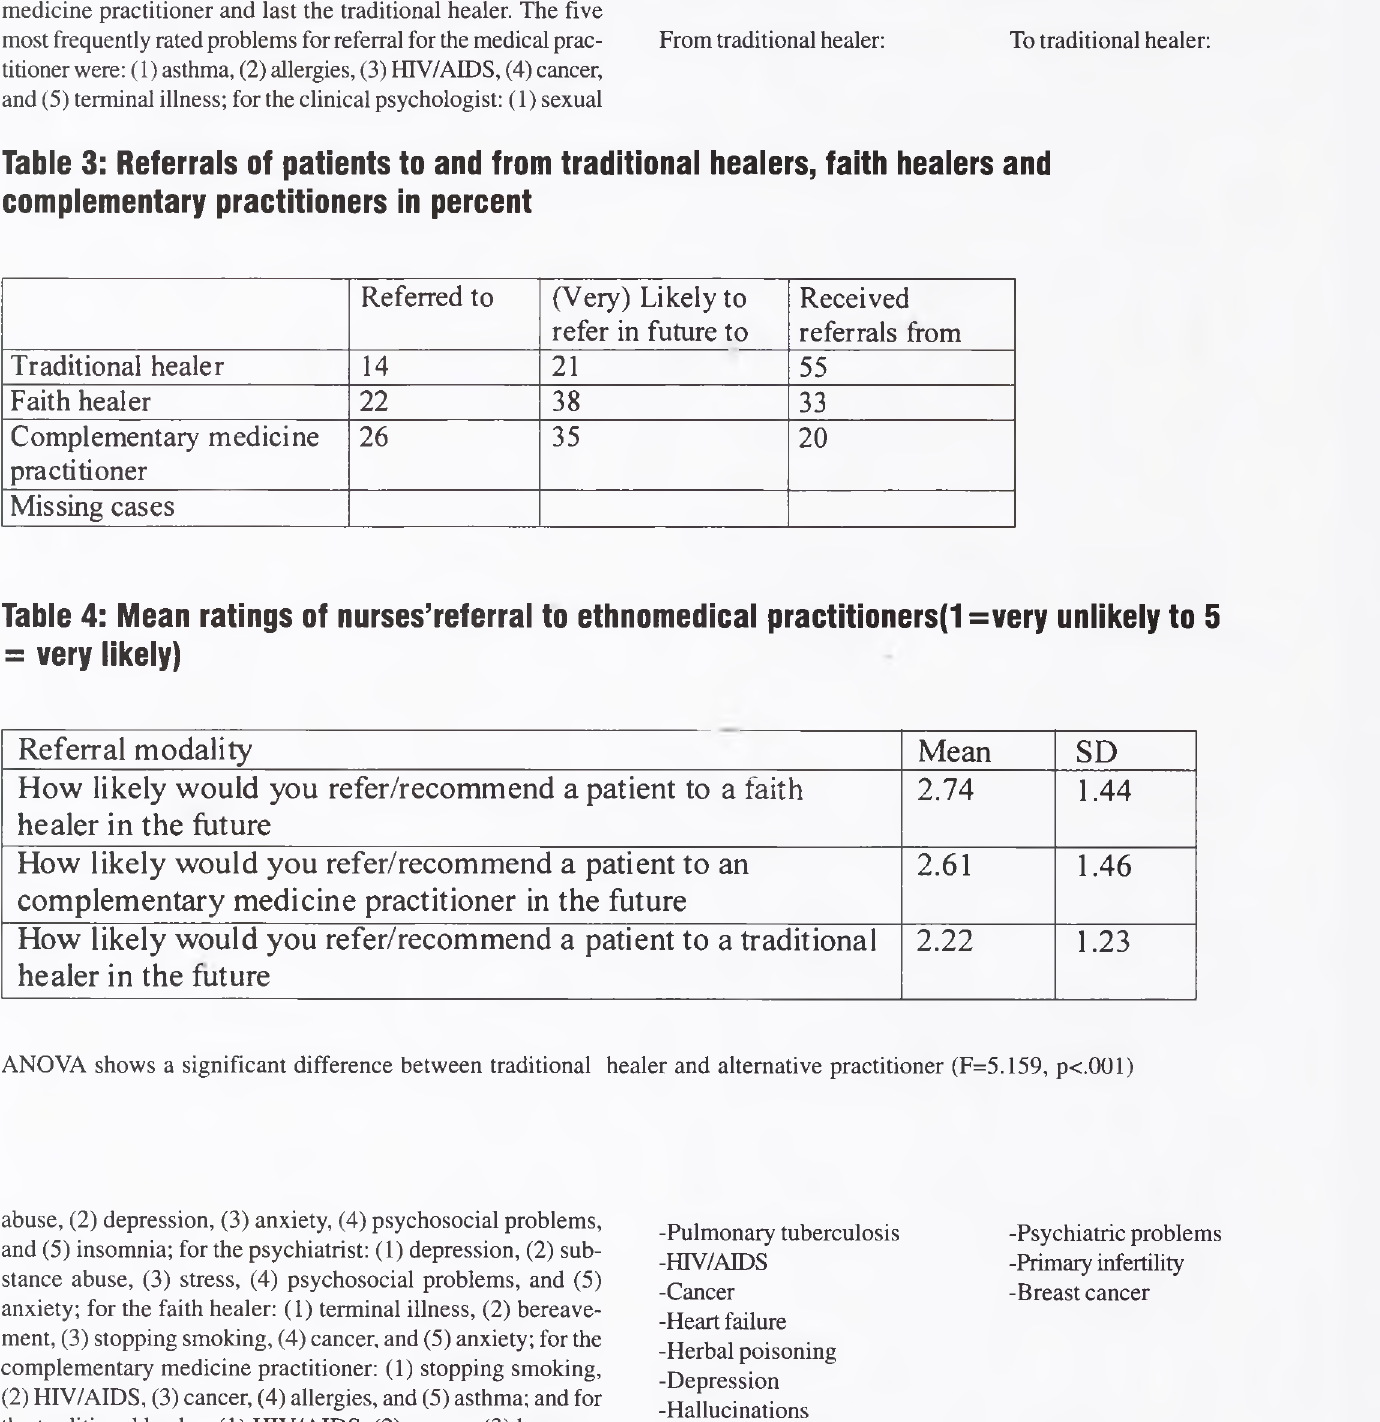
Table 4: Mean ratings of nurses’referral to ethnomedical practitioners(1 =very unlikely to 5 = very